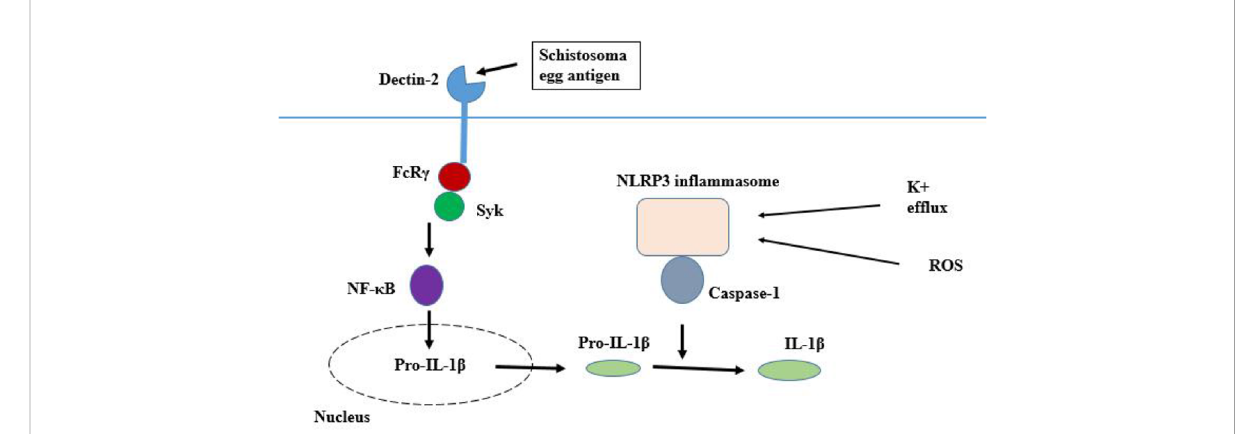
FIGURE 2 In fl ammasome pathway. Egg antigen triggers the Dectin-2 receptor that couples with the FcR g chain to activate the Syk kinase pathway, which controls the ROS and potassium ef fl ux dependent manner, NLR in fl ammasome activation and IL-1 b